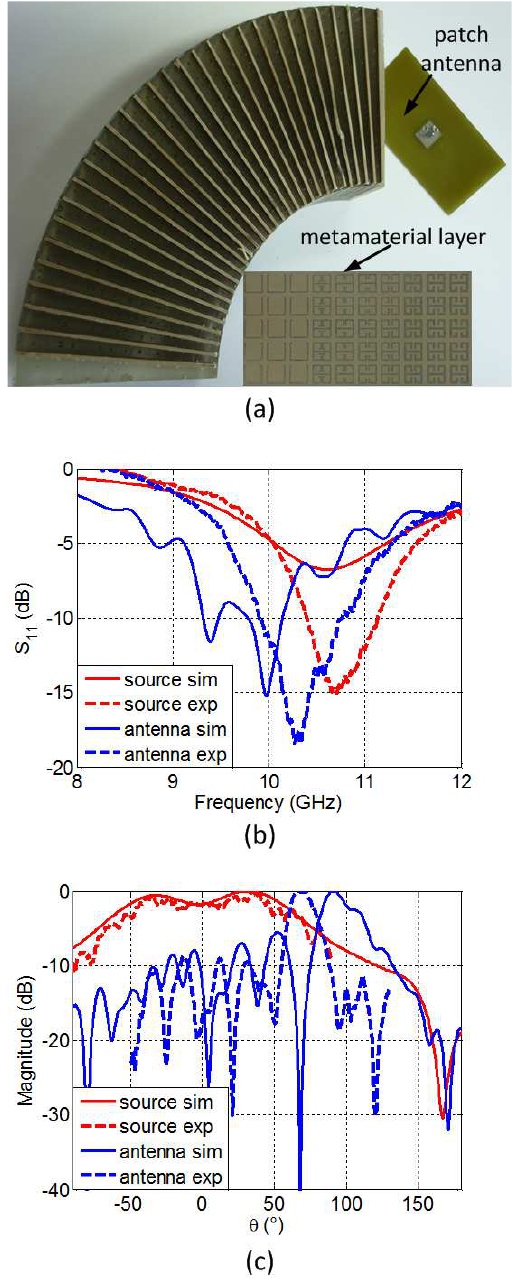
Figure 10: (a) Photography of the fabricated prototype. (b) Simulated and measured S 11 parameter of the patch source alone and the metamaterial antenna. (c) Far-field E-plane radiation patterns of the patch source alone and of the metamaterial